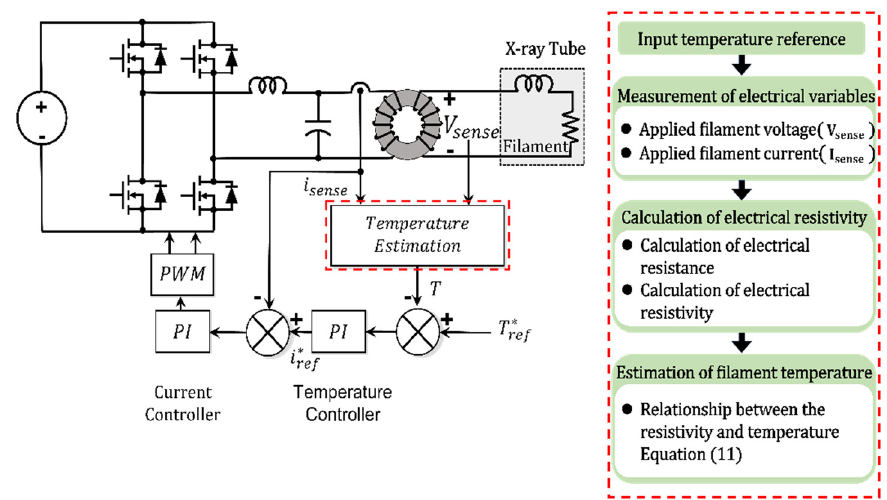
Figure 5. Filament driver circuit and control algorithm of the proposed